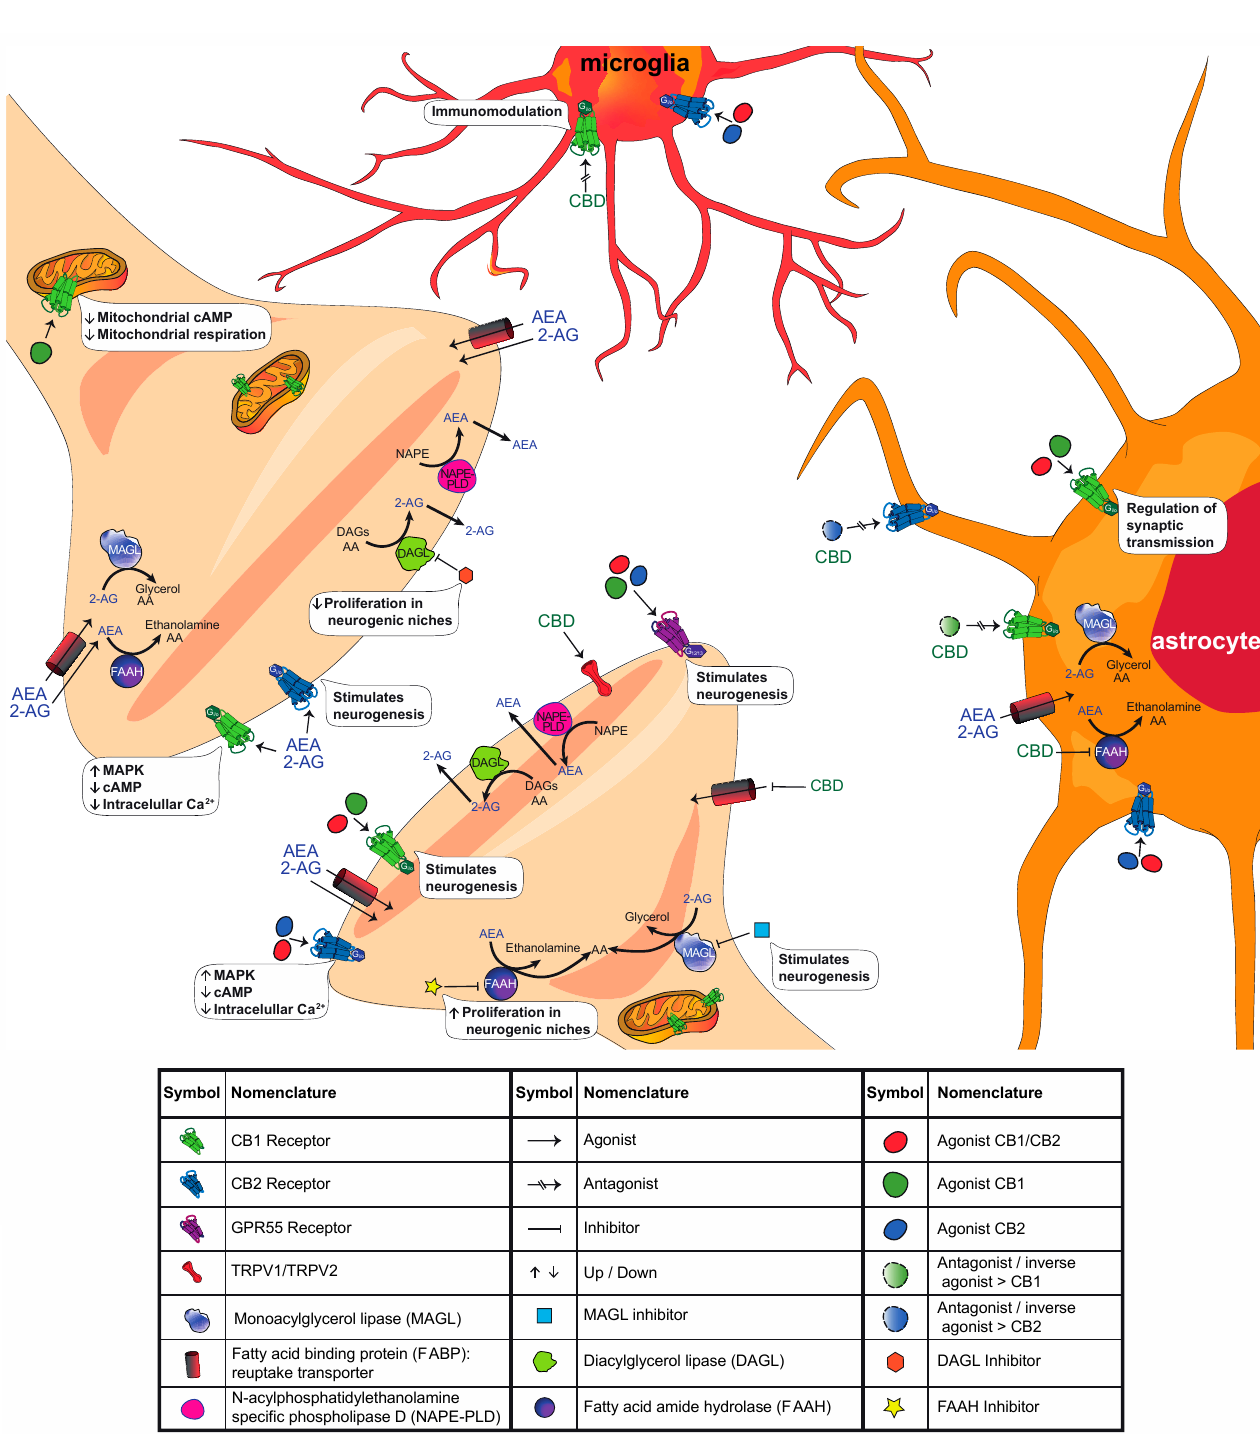
Figure 1. Schematic representation of cannabinoid function at the synapse. We depict the different components of the ECS (receptors, endogenous ligands, transporters across the membrane, biosynthetic and degradative enzymes) in neurons, astrocytes, and microglia. Some key effects elicited by the modulation of the ECS are highlighted. For a list of agonists, antagonist/inverse agonists and inhibitors, see Table 2. For more details, refer to the main text.